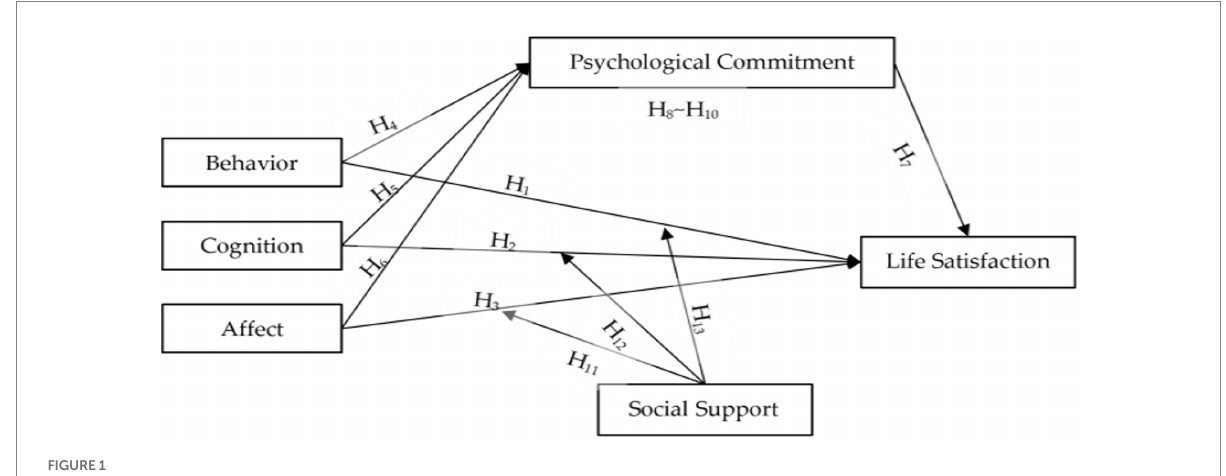
FIGURE 1 Proposed conceptual